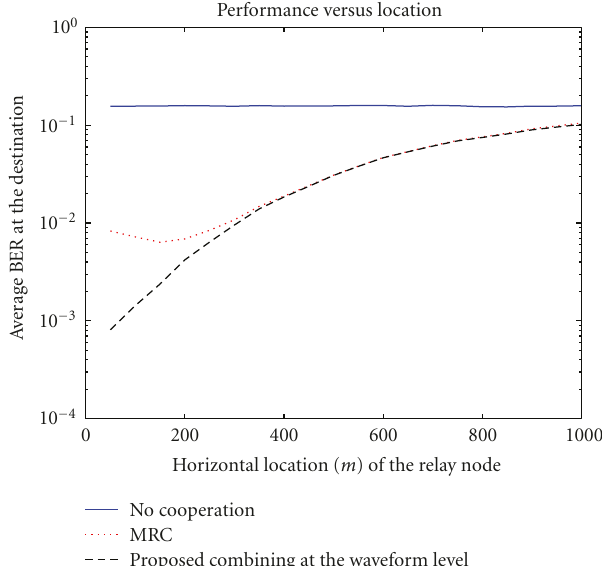
Figure 6: Average SNR over time with estimation error, malicious and selfish behavior (attacks at time 10 and time